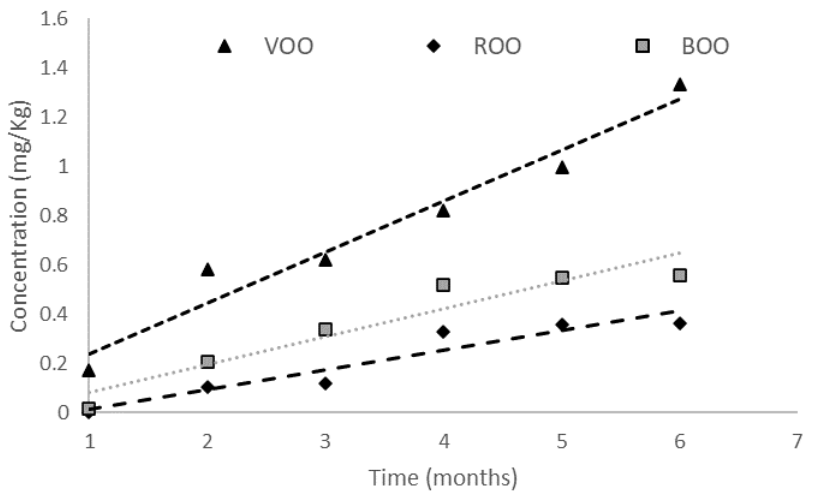
Figure 3. Variation in the concentration (mg/Kg) of nonanal in VOO, ROO and BOO samples throughout the storage.